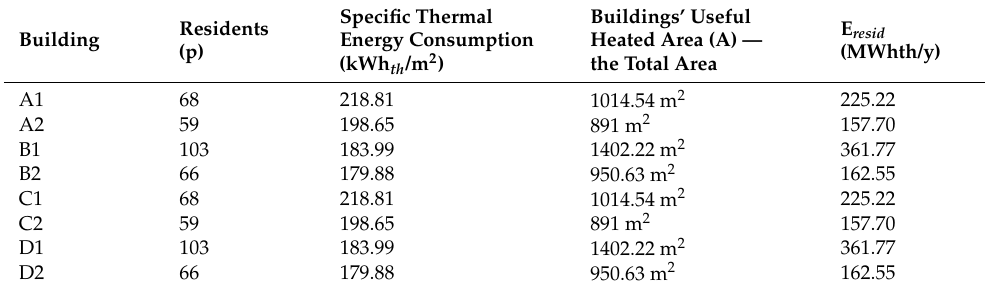
Table 2. Case study’s building characteristics and the E resid . calculated with KIM Equation